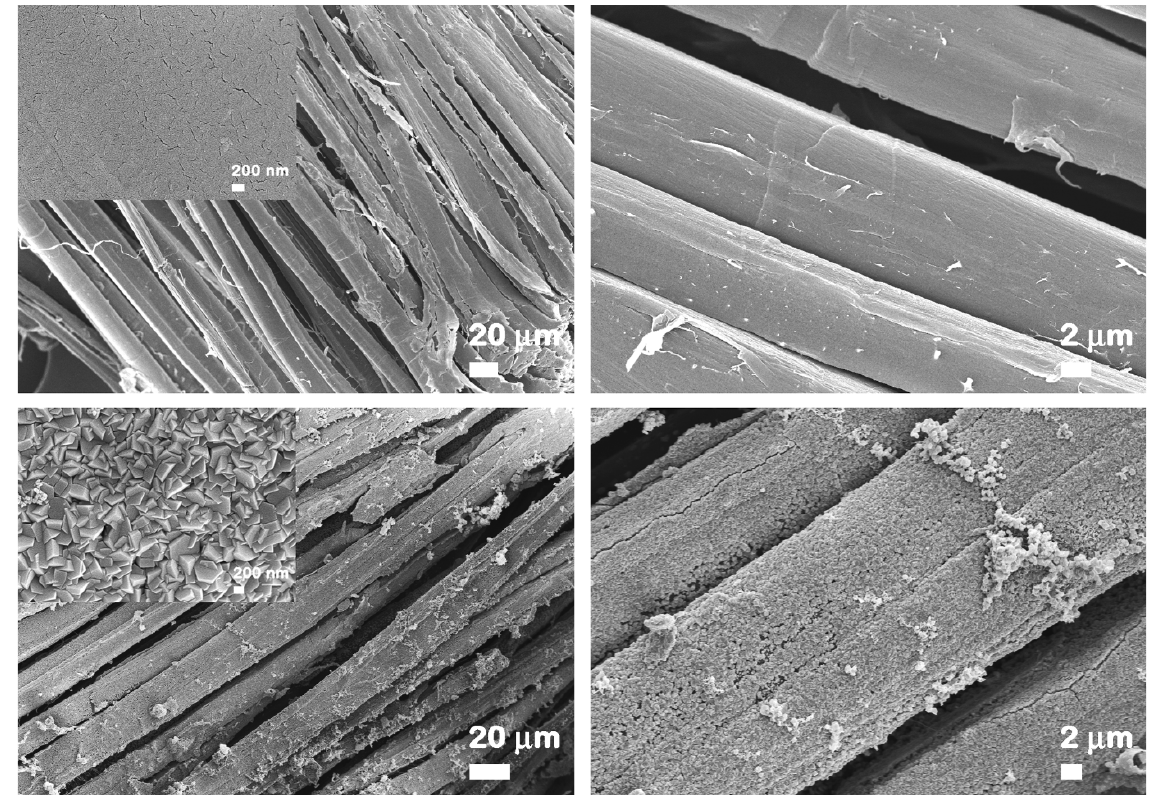
Figure 3. FESEM images at different magnifications of flax fibers ( top ) and ZnO-coated flax fibers ( bottom ) as fabrics.